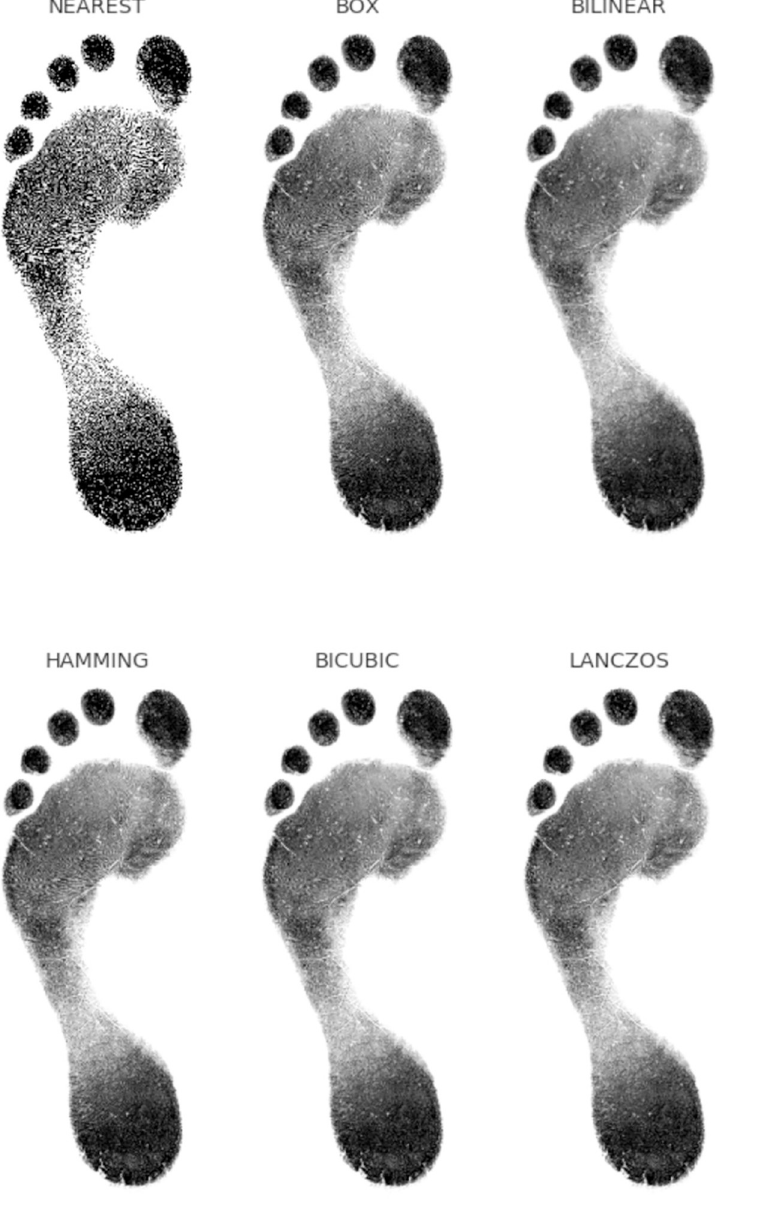
Fig 2. The results of different resizing